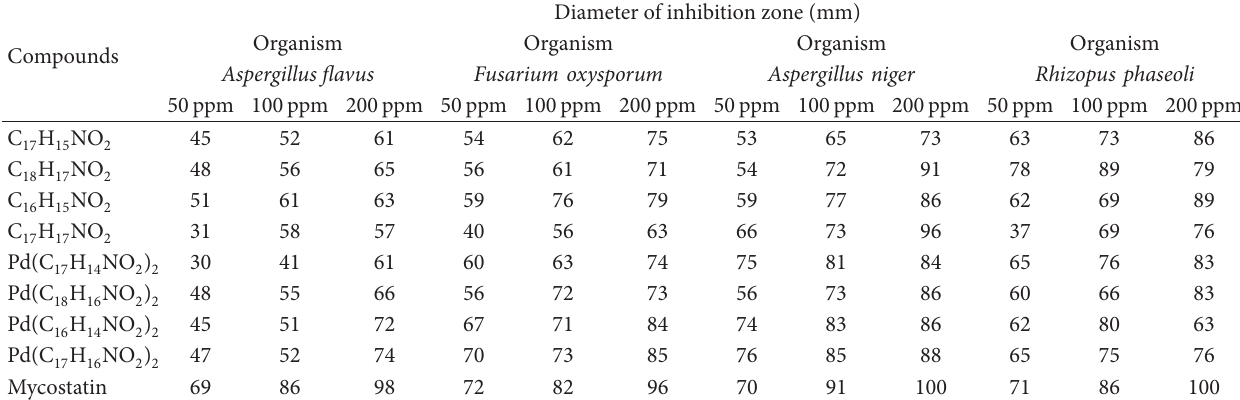
T 3: Antibacterial screening data of the azomethine derivatives of amino acid and their Pd(II) complexes. Inhibition zone (mm) aer 24h (concentration in ppm).